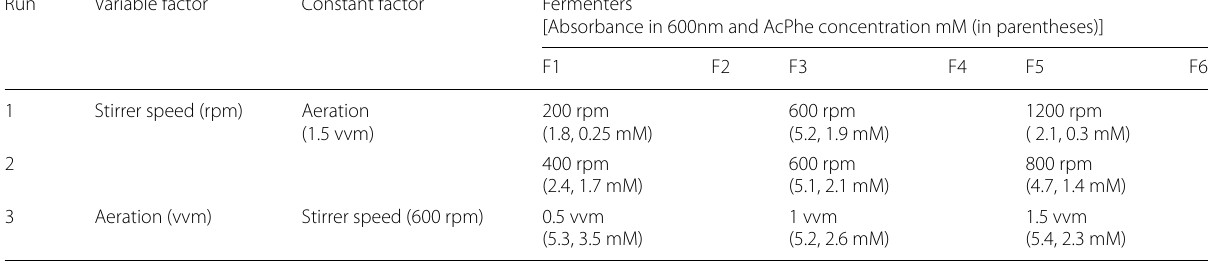
Table 4 The design and result of one-factor-at-time for optimization of biomass production in bioreactor Run